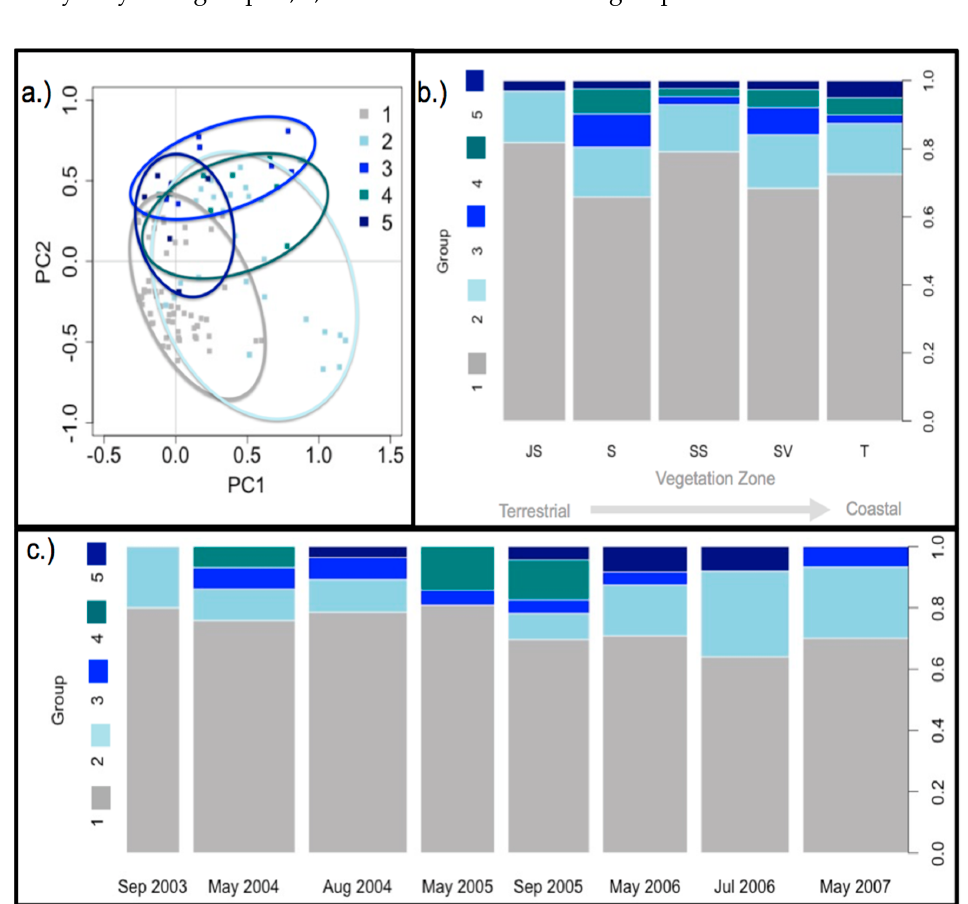
Figure 10. ( a ) Ordination and ( b ) variation in assemblage groups by vegetation zone (JS = high marsh Juncus roemerianus ; S = low marsh short form S. alterniflora ; SV = high marsh Salicornia virginica ; SS = mid ‐ marsh mixed zone of co ‐ occurring S. virginica and short form Spartina alterniflora ; T = low marsh tall form S. alterniflora ) and ( c ) over time. The width of each block is proportional to the number of core samples with successful DNA isolation and subsequent DGGE gel analysis.